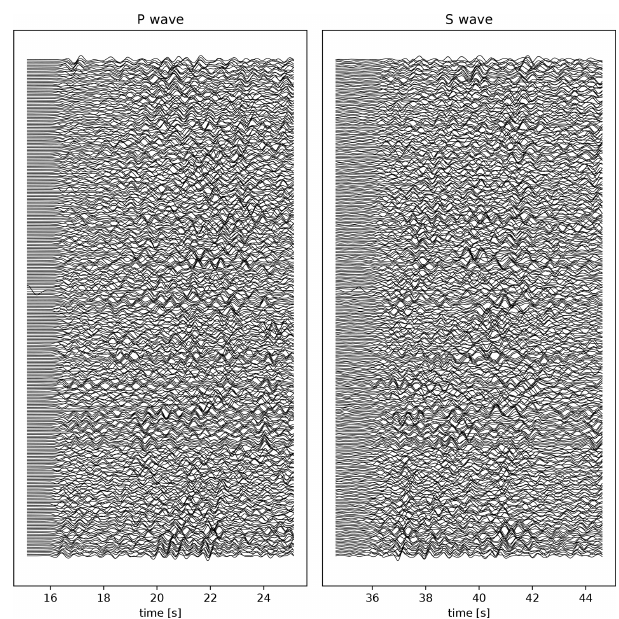
Figure 6. P and S waveforms recorded by the DAS array, ordered by distance from the earthquake epicentre, filtered in a 0.5–2Hz pass band, and scaled by the standard deviation of each trace. Time is relative to the start of the recordings and is synchronised with the waveforms shown in Fig. 1. For clarity, only every 20th channel waveform is